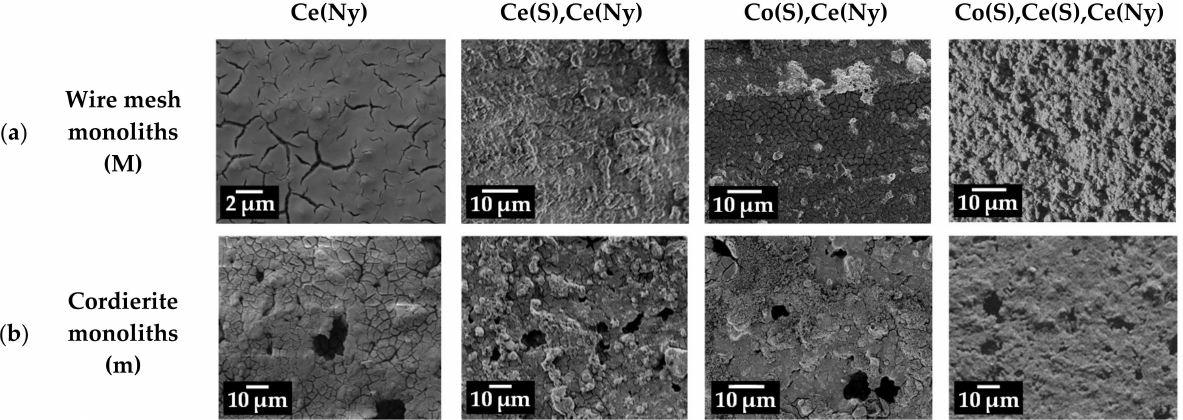
Figure 6. SEM micrographs of the central sections of ( a ) the intermediate wire mesh of metallic monoliths and ( b ) the inner channels of cordierite